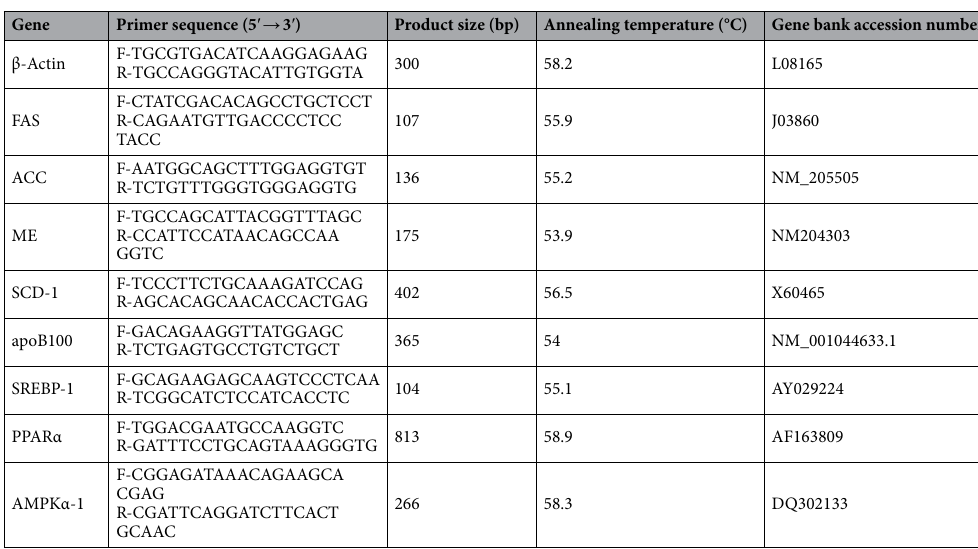
Table 6. Nucleotide sequences of specific PCR primers of different genes. ACC Acetyl-CoA carboxylase, FAS Fatty acid synthase, ME Malic enzyme, SREBP Sterol regulatory element binding protein, SCD-1 Stearoyl-CoA (Δ9) desaturase, PPAR-α Peroxisome proliferator activated receptor, AMPK AMP-activated protein kinase, apoB100 Apolipoprotein